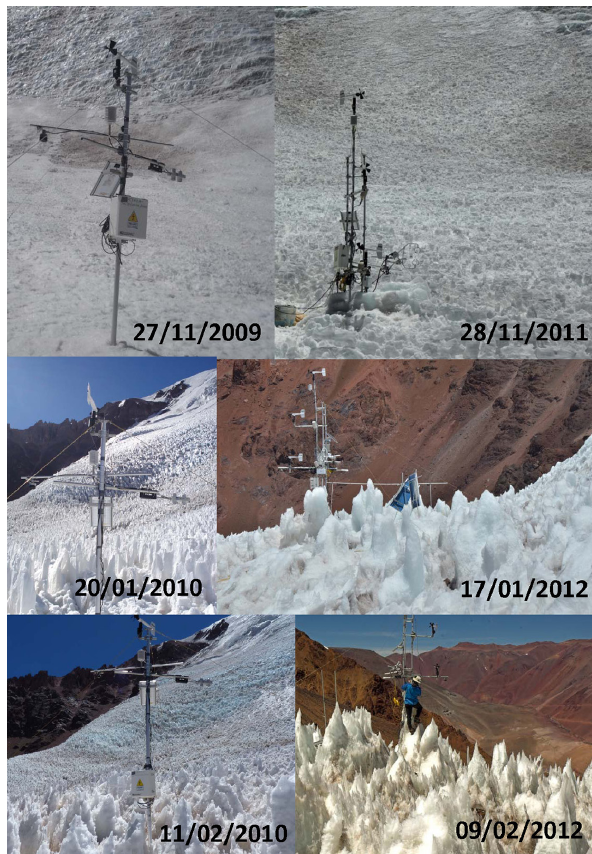
Figure 12. Compilation of photographs from the AWS during the seasons 2009/2010 (left side) and the respective nearest available point in time in 2011/2012 (right side). Note the different penitente heights from since the beginning and their evolution throughout the season (Fotos: CEAZA glaciology